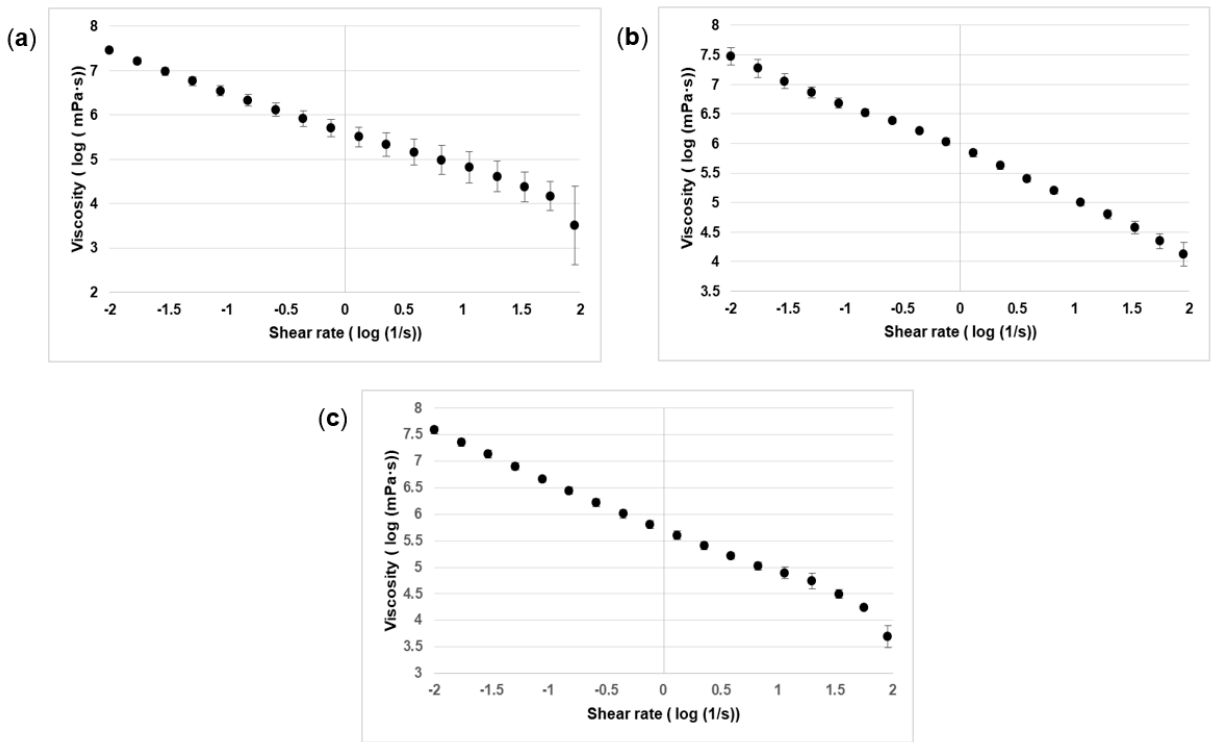
Figure 6. Rheological properties. ( a ) Viscosity/shear rate curve of bioprinted constructs with 1 million NPCs and microspheres. ( b ) Viscosity/shear rate curve of bioprinted constructs with 2.5 million NPCs and microspheres. ( c ) Viscosity/shear rate curve of bioprinted constructs with 5 million NPCs and microspheres.